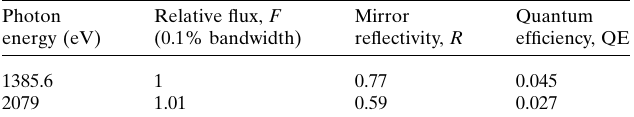
Table 4 Some parameters of JUMBO at the SPEAR storage ring used for calculations.